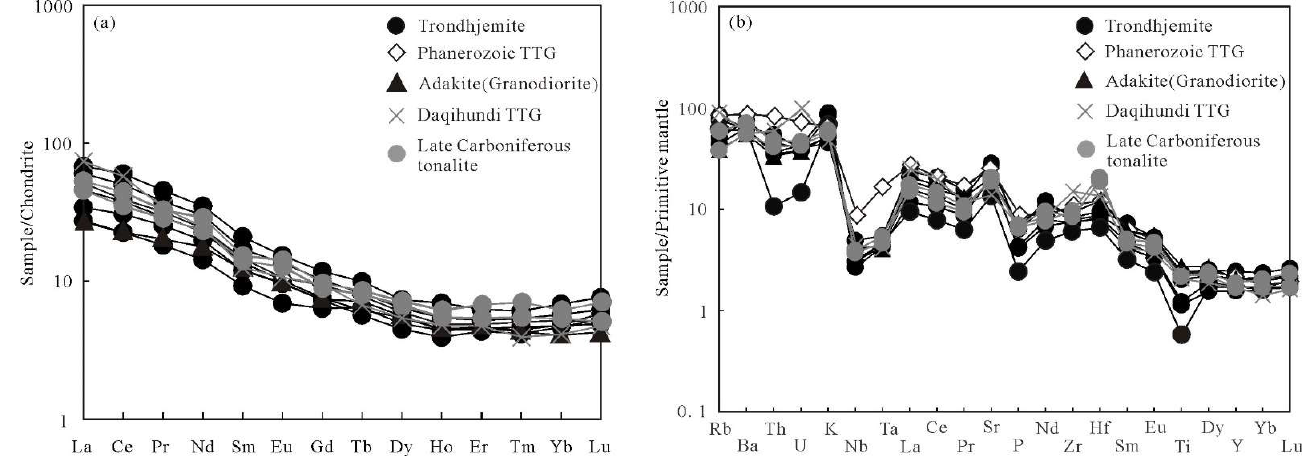
Figure 6. ( a ) Chondrite-normalized REE distribution patterns and ( b ) primitive mantle-normalized trace-element diagram for the Gaolihan trondhjemite. The normalizing values are from Sun and McDonough [47]. Phanerozoic TTG data from Condie [6]; adakite (granodiorite) data from Wang et al., 2020 [48]; Daqihundi TTG data from Fan 2020 [40]; Late Carboniferous tonalite data from Wang et al., 2021 [41].